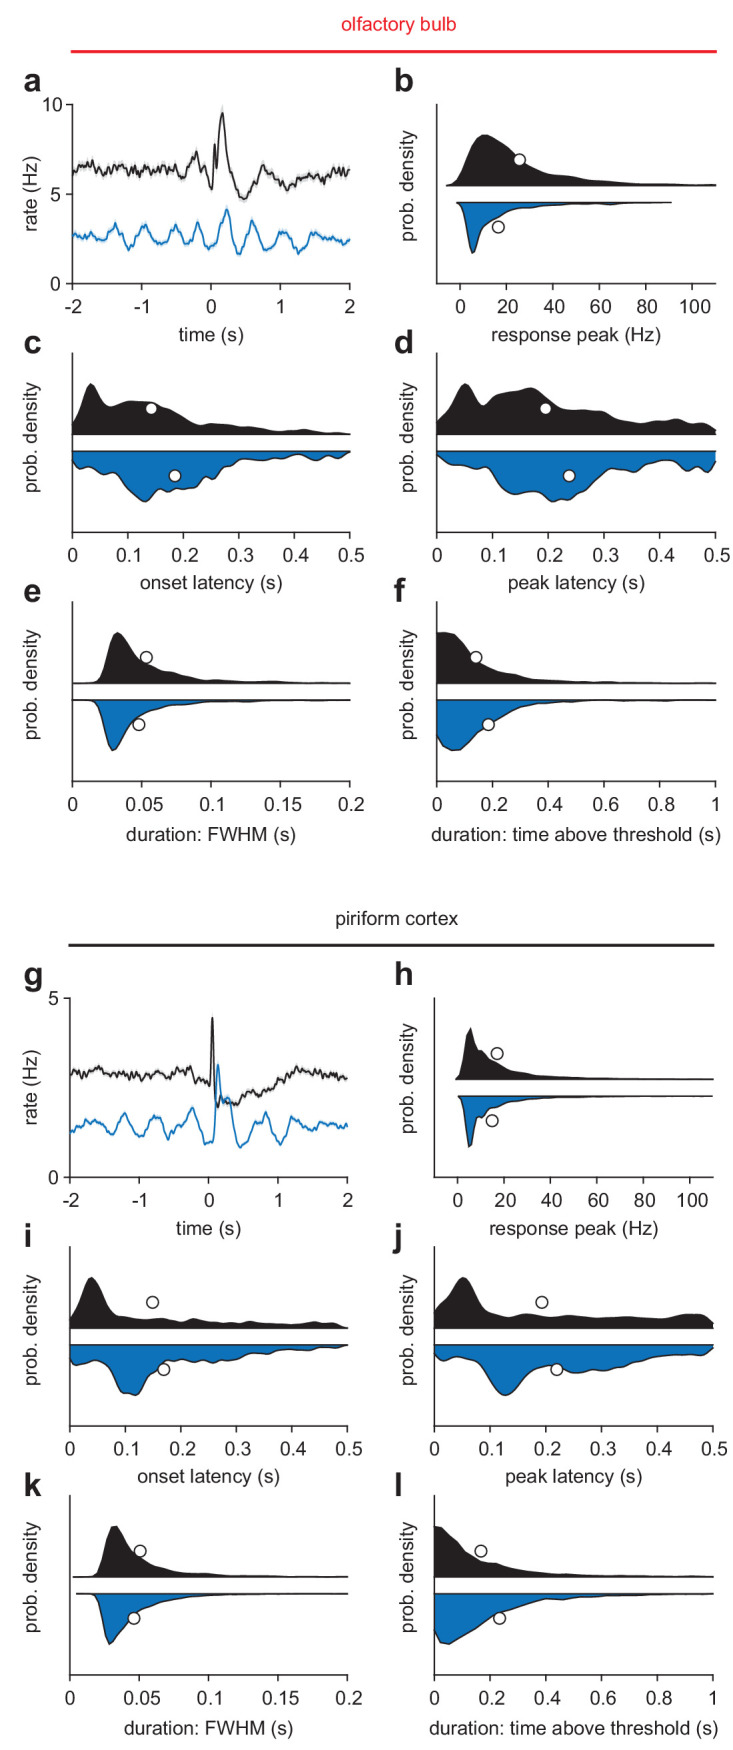
Odor response characteristics during awake and anesthetized trials.(a) Average odor response for all OB cell-odor pairs during awake (black) or k/x (blue) trials (n = 1122 cell-odor pairs, mean ± sem). (b–f) Responses with any peak in the 500 ms following inhalation were identified and their response features characterized. Awake, n = 1059; K/X, n = 799 cell-odor pairs. (b) Response peak is the maximum of the cell-odor PSTH within 500 ms. (c) Onset latency is the latency to cross a threshold of 2.5 s.d. above the 3 s pre-odor baseline. (d) Peak latency is the time of the maximum of the cell-odor PSTH within 500 ms. (e) Response duration measured as full-width at half-maximum in the first 500 ms. (f) Response duration measures as time above a 2.5 s.d. threshold. This accounts for multiphasic responses that may have sharp initial peaks followed by later, lower amplitude rate increases. Awake responses tended to be larger and lower latency, with slightly wider peaks but shorter overall responses. (g–l) As in a-f, but for PCx.